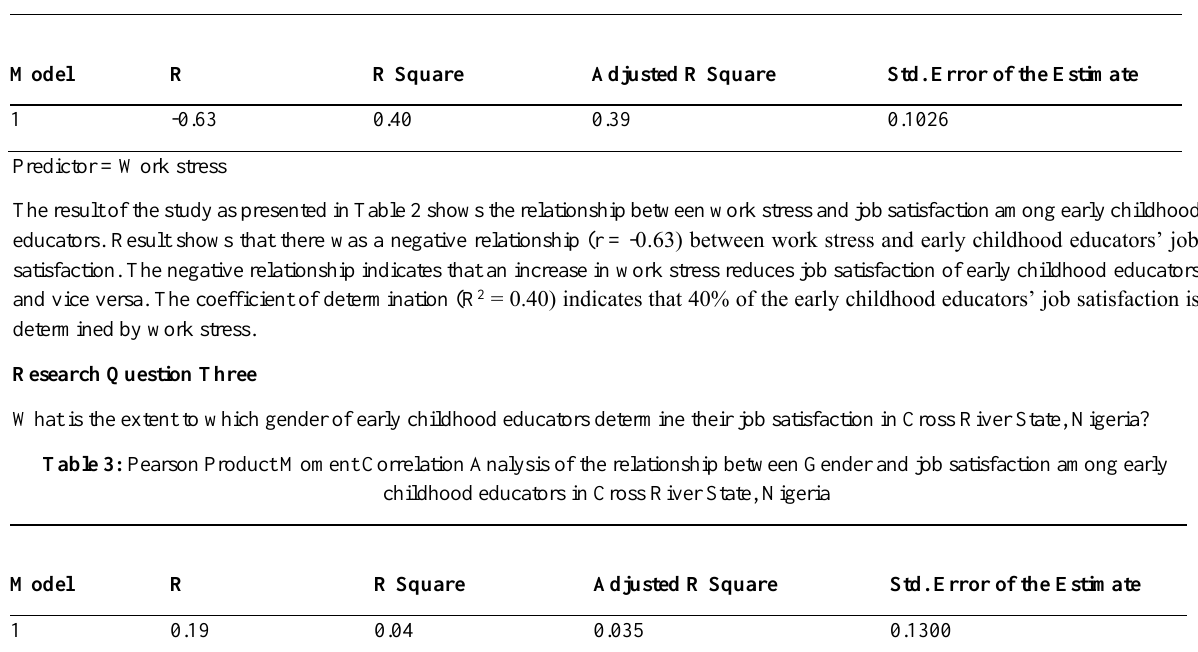
Table 2: Pearson Product Moment Correlation Analysis of the relationship between work stress and job satisfaction among early childhood educators in Cross River State, Nigeria